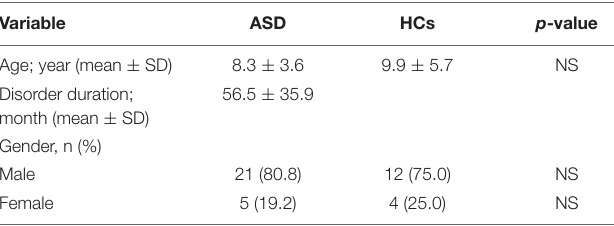
TABLE 1 | Demographic and clinical